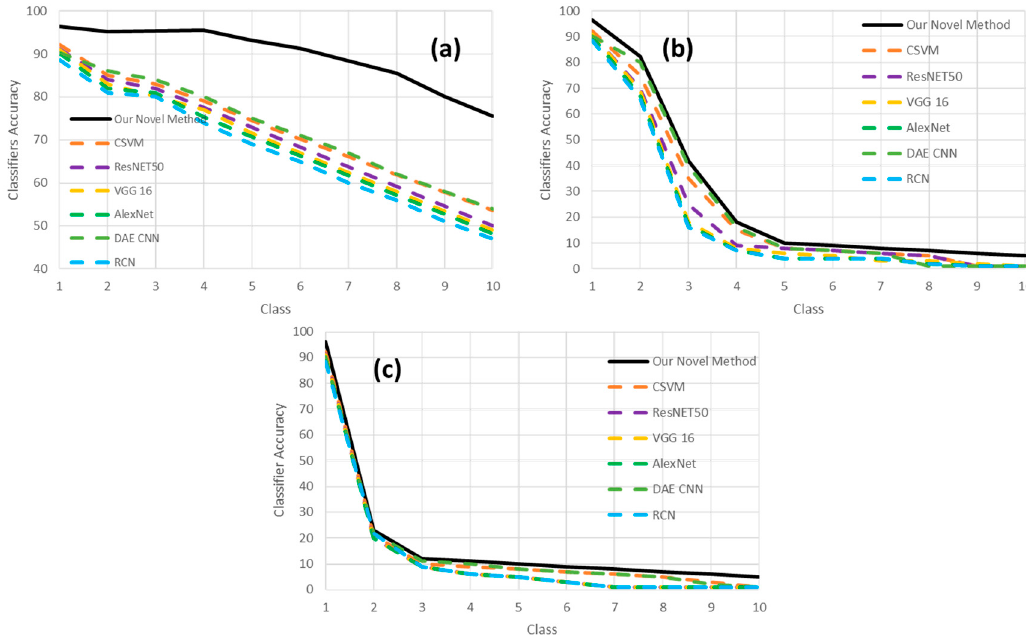
Figure 16. The effect of different artifacts on our best classifier’s accuracy (Model V) and a comparison with other related works. The class value (on the x-axis) shows the amount of injected distorting artifacts (i.e., distortion level) in the original clean image based on the parameter sets presented in Table 4. Three scenarios are considered: ( a ) Effect of Gaussian noise injection; ( b ) effect of focus blur injection; and ( c ) Effect of combined artifacts